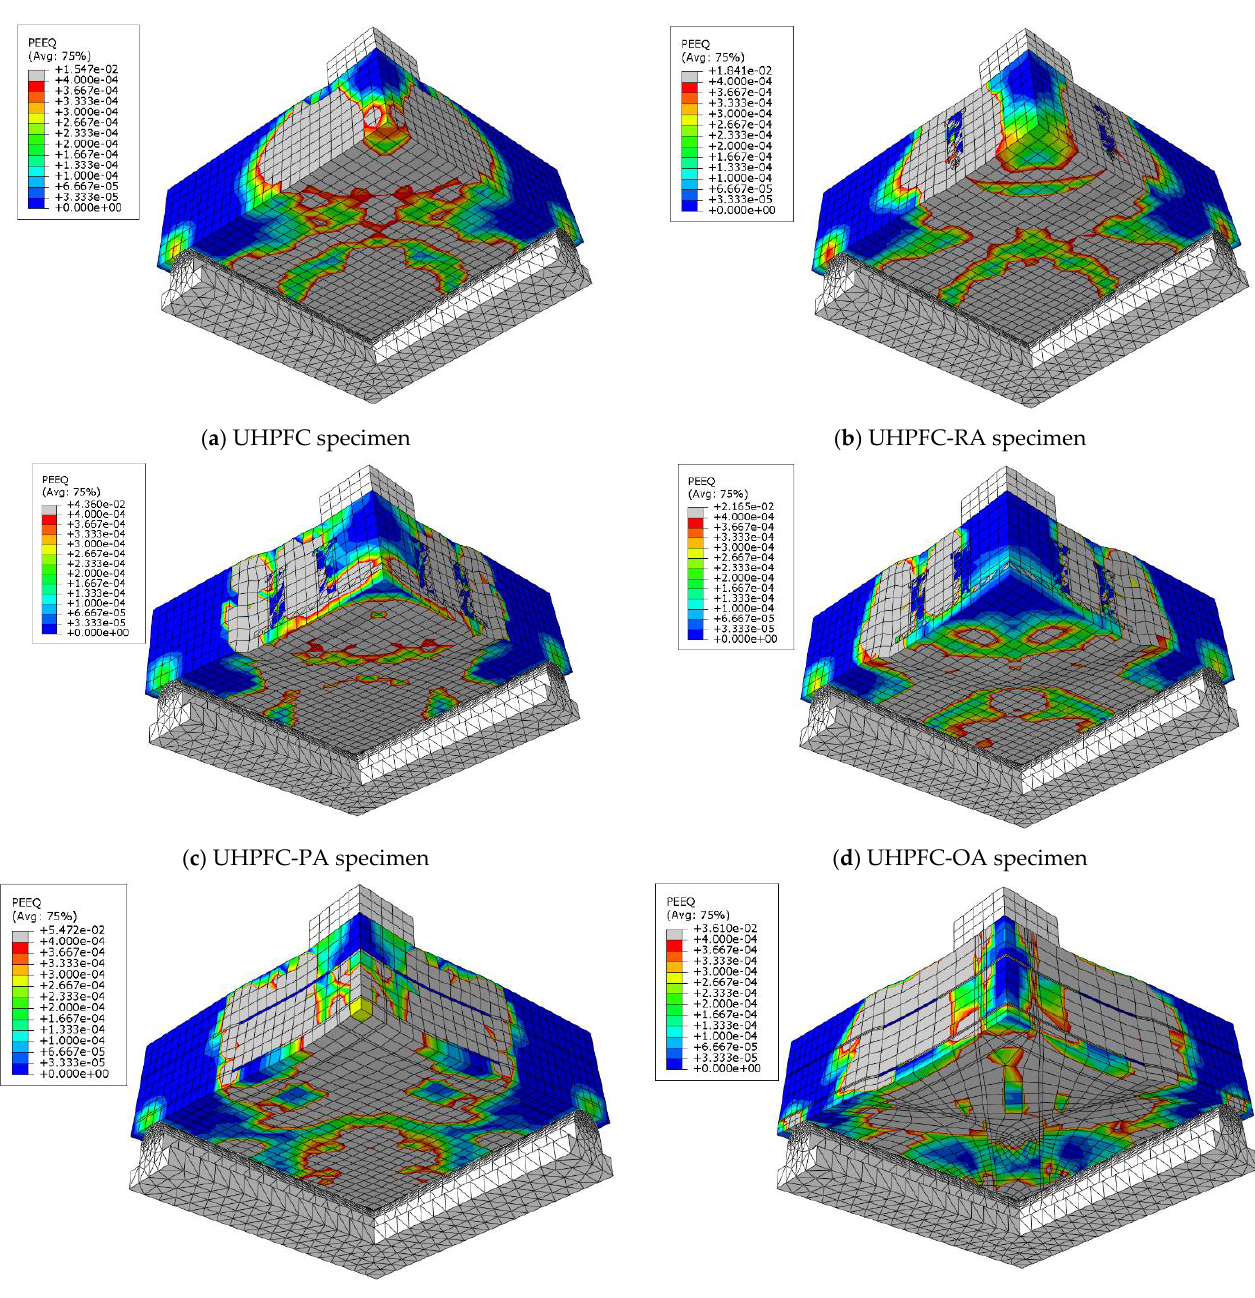
Figure 24. Analytical UHPFC specimens cracks. Table 5. Difference between numerical model and experimental results.